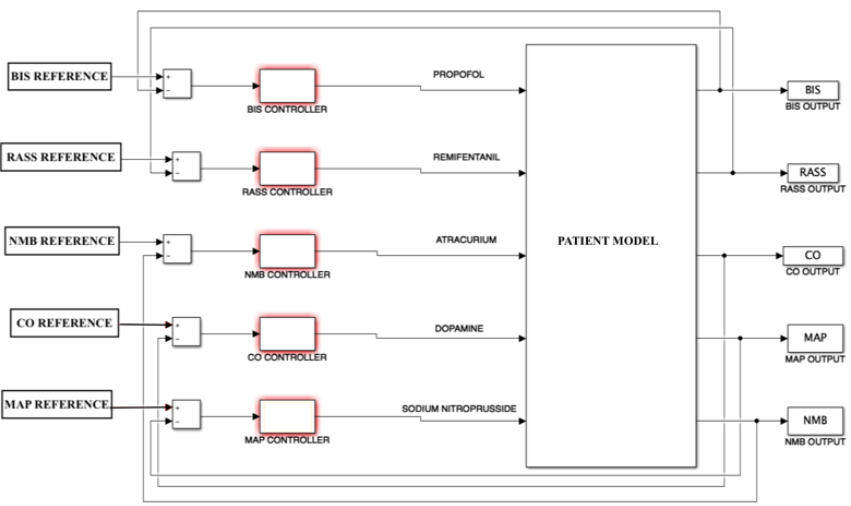
Figure 3. Block diagram of the control system for the anesthesia and hemodynamic states.